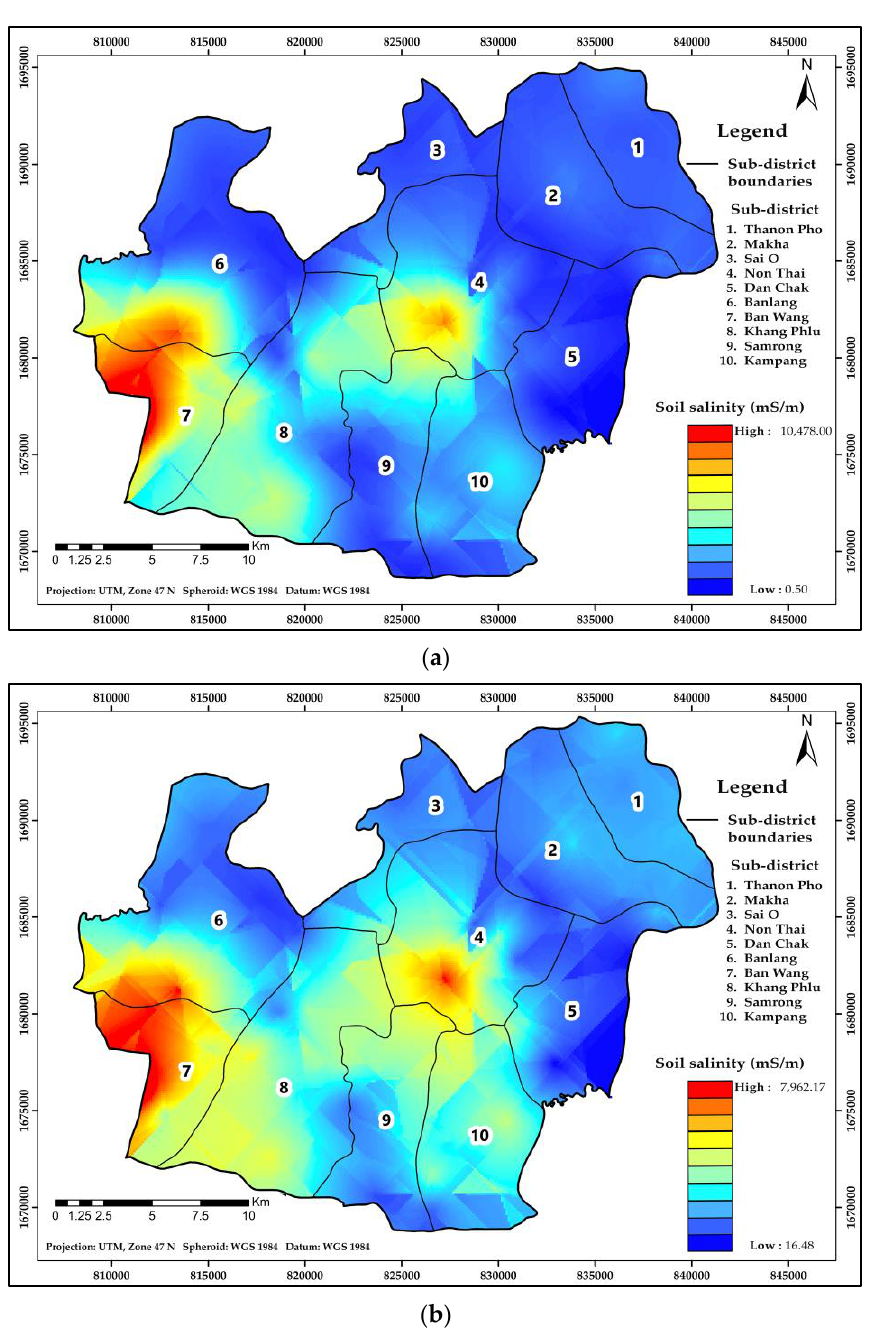
Figure 11. Spatial distribution of soil salinity prediction using OCK of two measuring modes: ( a ) HH and ( b ) VV.